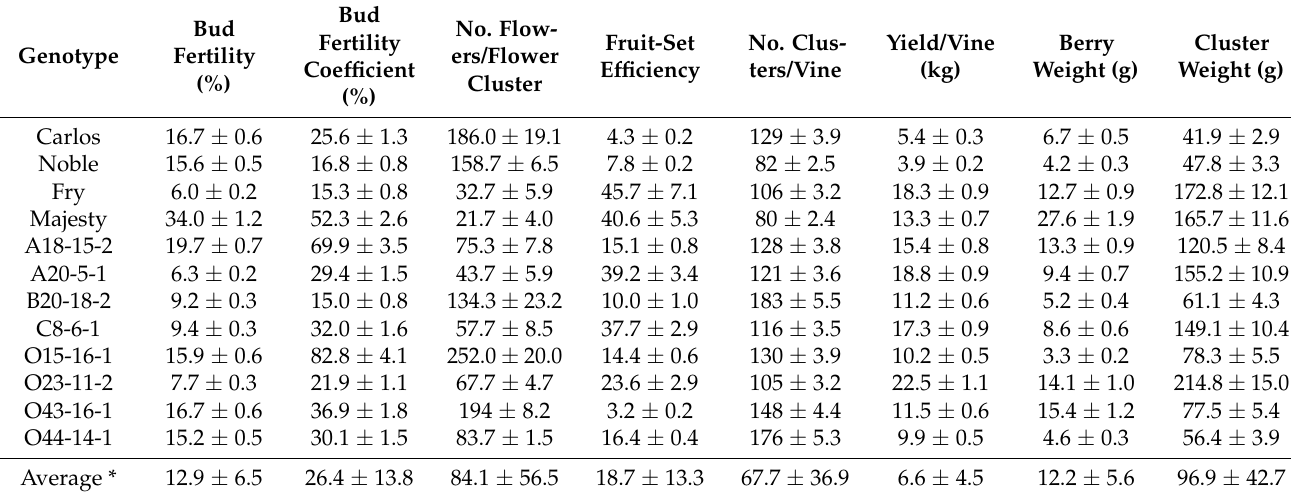
Table 1. Characteristics of selected genotypes to promote new standard